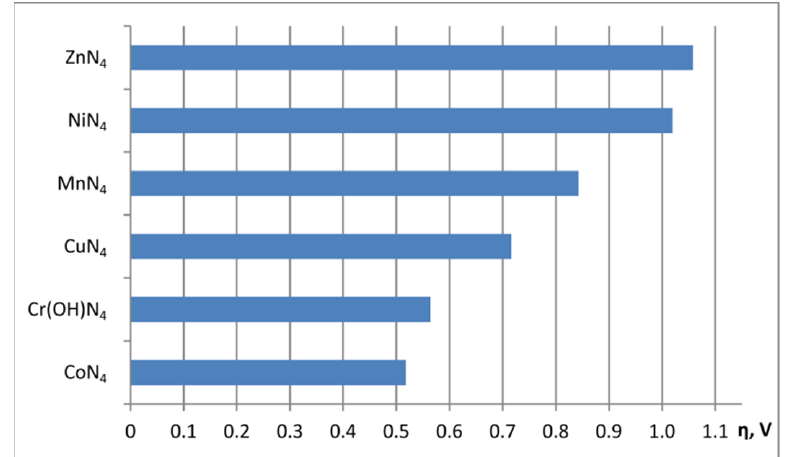
Figure 5. Overpotential on catalysts.